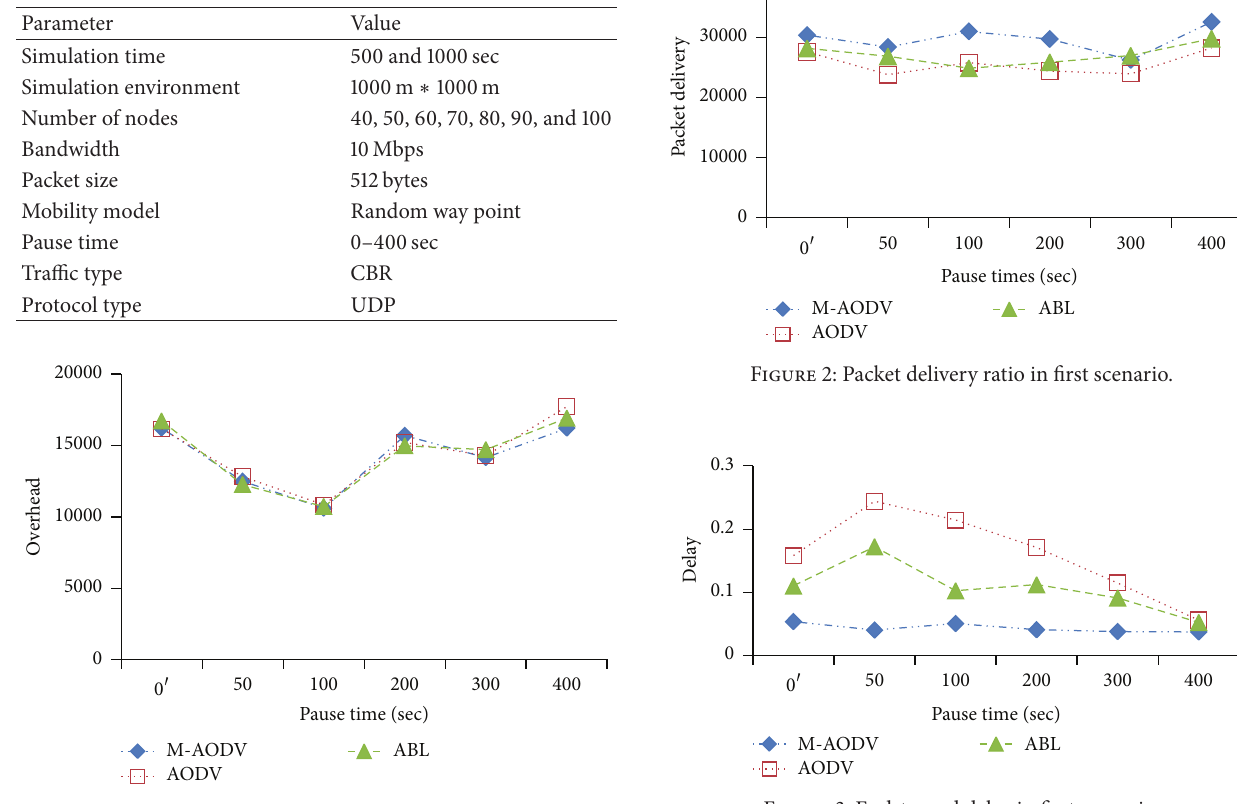
Figure 1: Control overhead in first scenario.